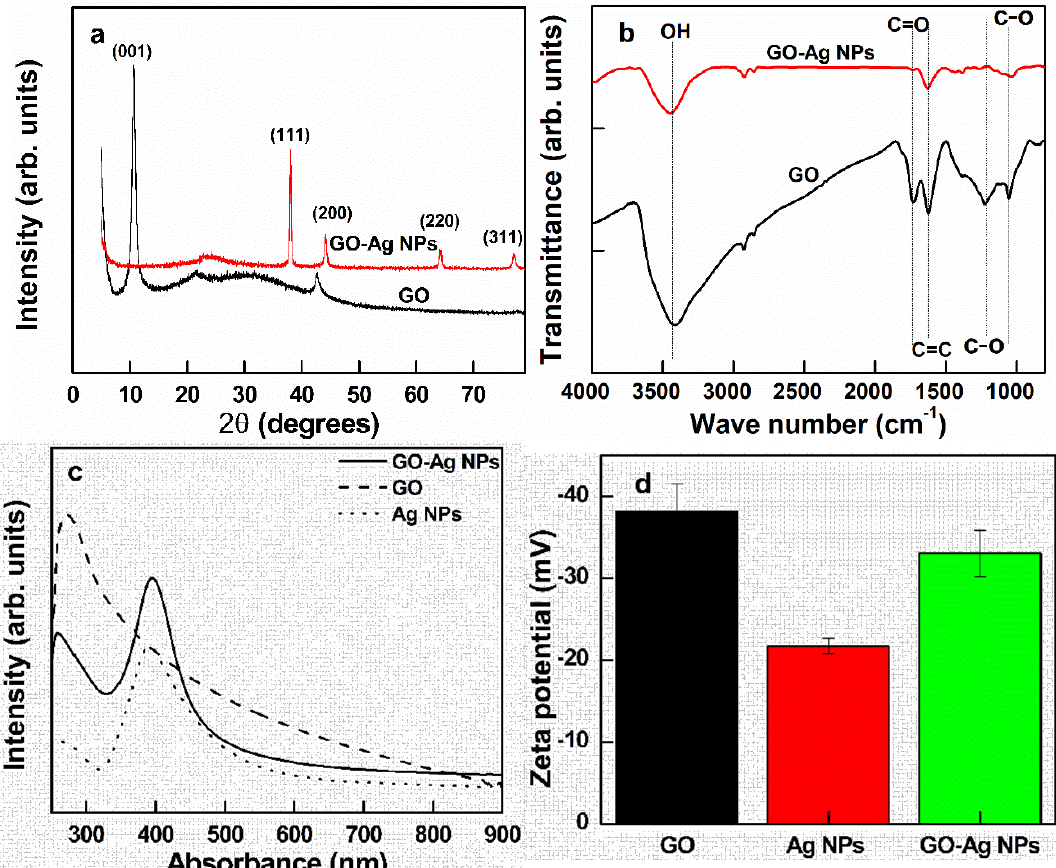
Figure 2. XRD patterns ( a ) and FTIR spectra ( b ) of GO and GO–Ag NPs; UV spectra of GO, Ag NPs and GO–Ag NPs ( c ); Zeta potential profiles of pure GO, Ag NPs, and GO–Ag NPs ( d ). The error bars in ( d ) represent the standard deviations of the data performed in triplicate ( n = 3).